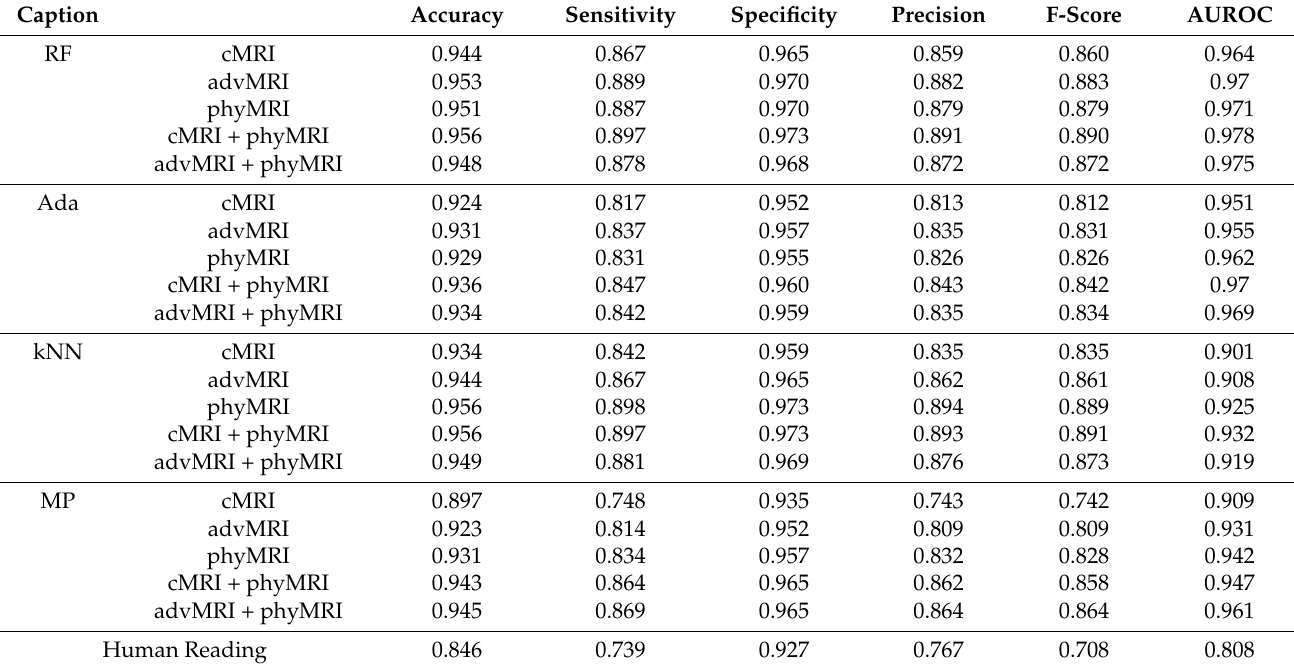
Table 3. Diagnostic performance of the four selected ML classifiers and the human readers in the learning/validation cohort.